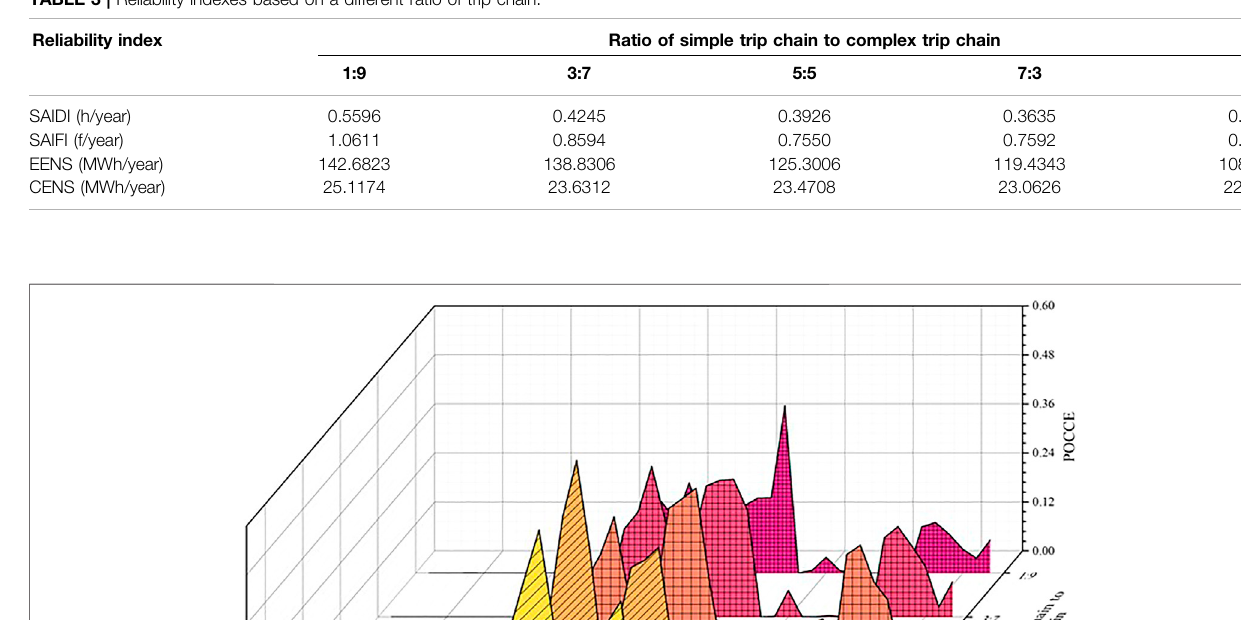
TABLE 3 | Reliability indexes based on a different ratio of trip chain.